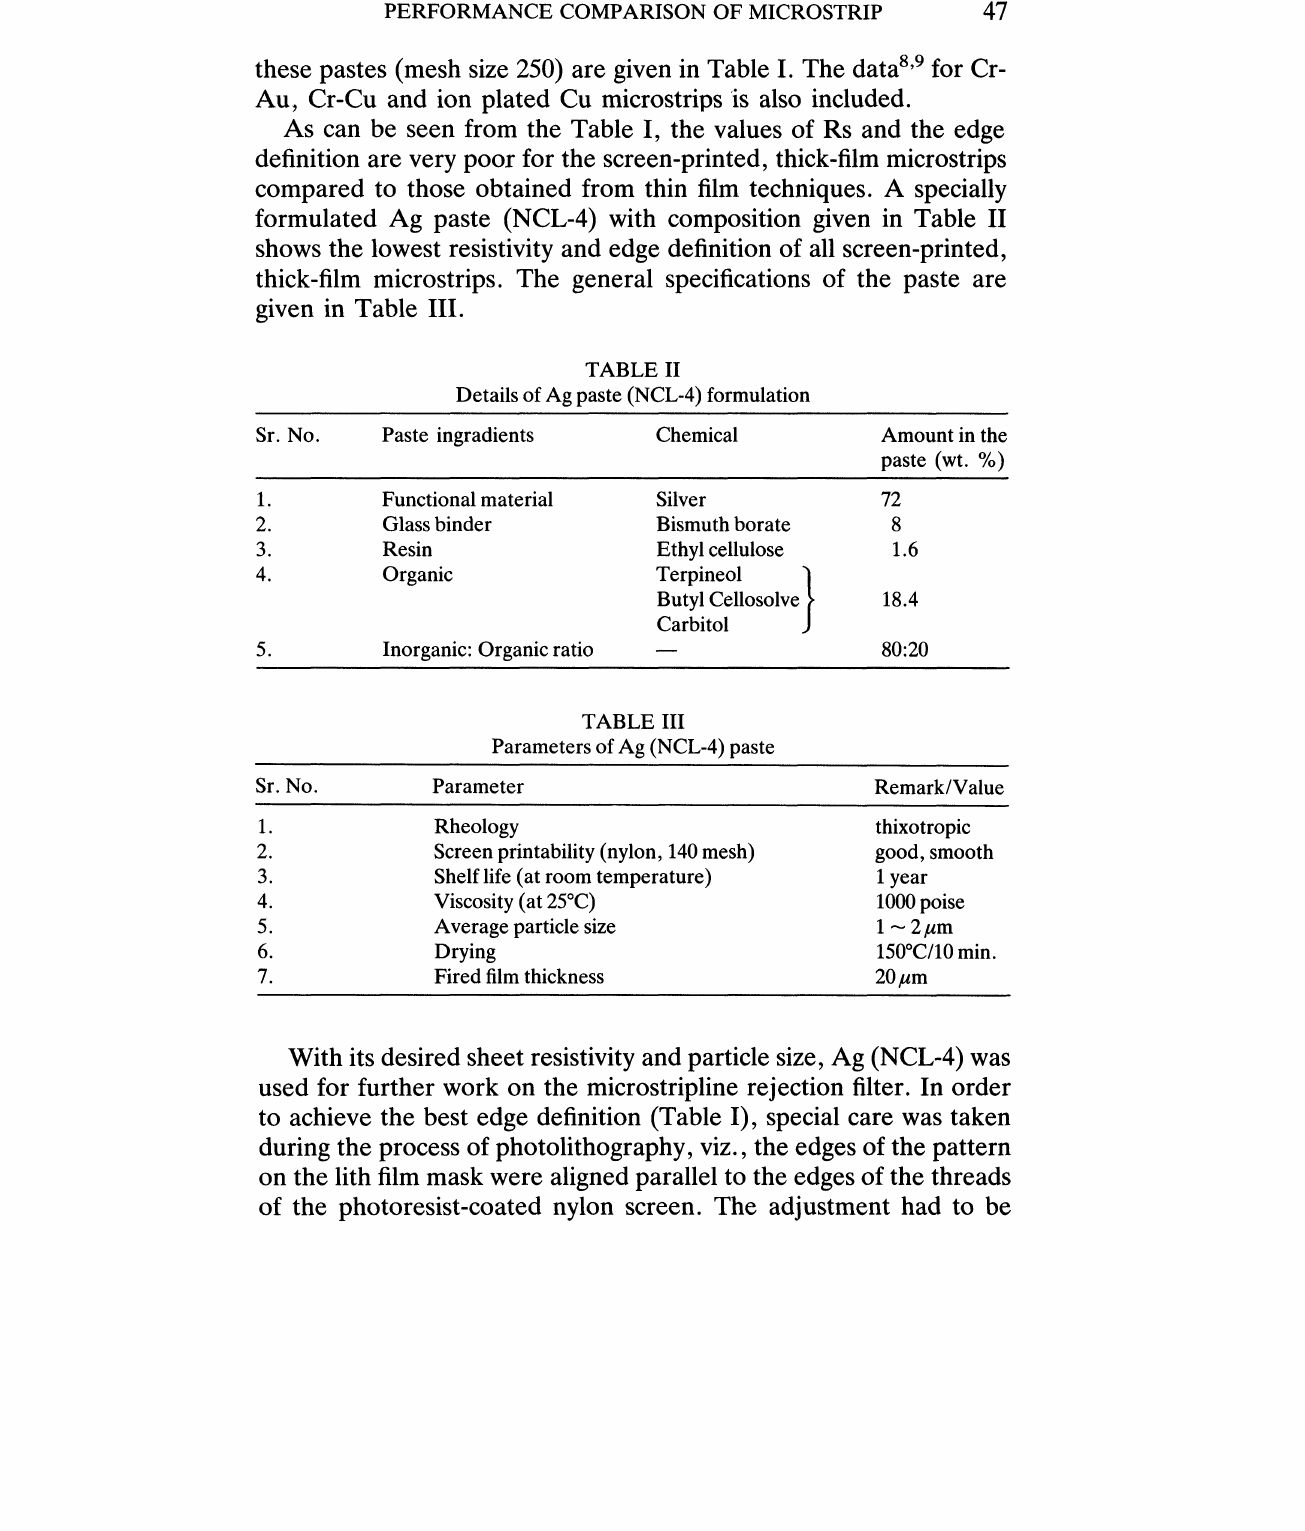
Details of Ag paste (NCL-4) formulation